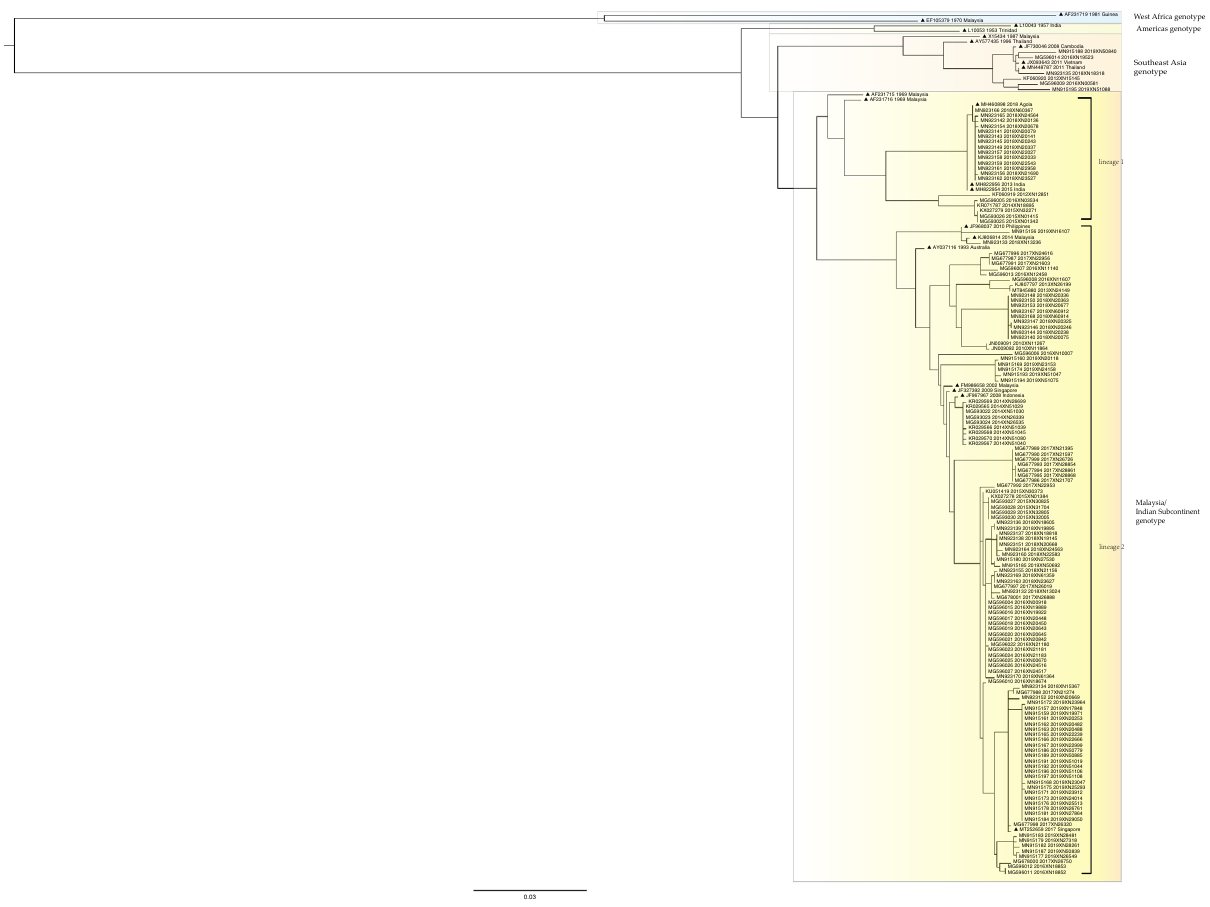
Figure 3. Phylogenetic tree of DENV2 E gene sequences. The reference sequences are indicated with black triangles for clarity, with the accession number, and year and country of isolation. Sequences detected in Guangzhou between 2010 and 2019 are indicated with the accession number, year of isolation, and the laboratory